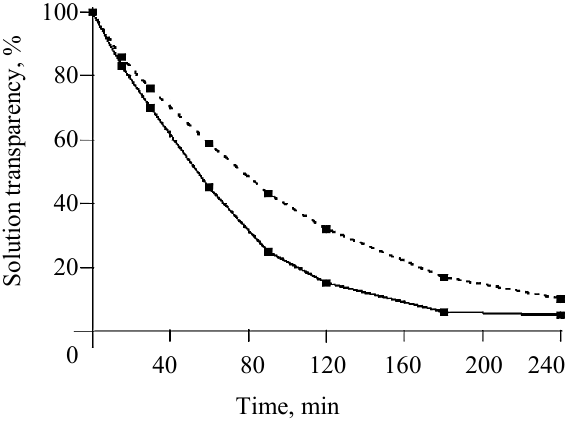
Fig. 7. Change in the transparency of the solution during the nucleation of anhydrous glucose with a seed from the large (200 μm) hydrate glucose crystals wet with propanol at a temperature of 48°C and ΔC, g/100 g of water: _ _ _ 80, _____